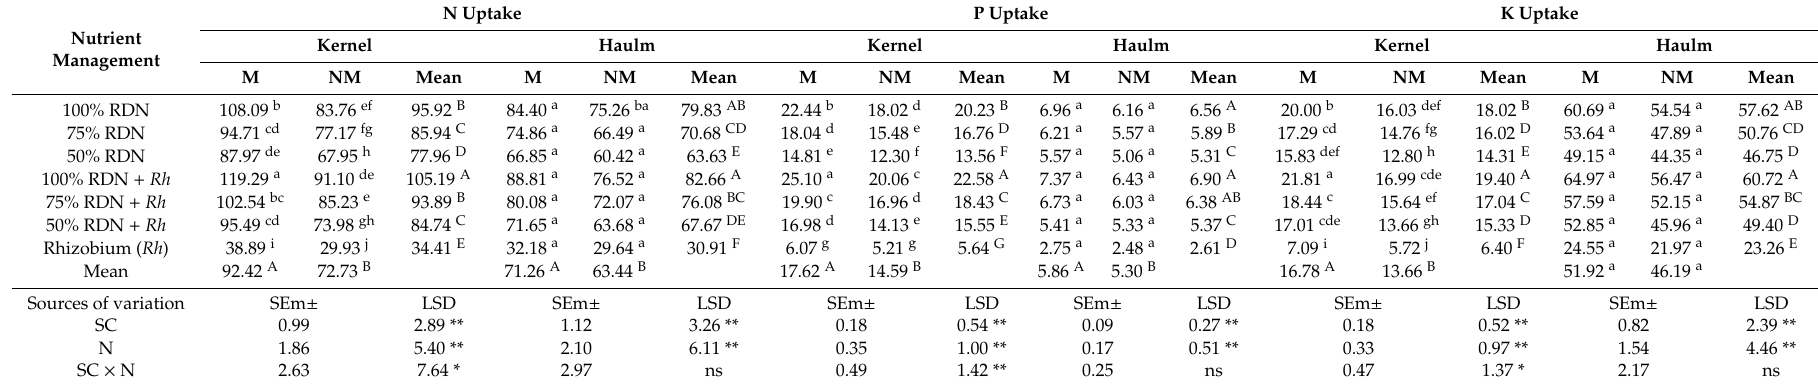
Table 5. E ff ect of soil covering and nutrient management on Nitrogen (N), Phosphorus (P) and Potassium (K)uptake in di ff erent plant parts of peanut in